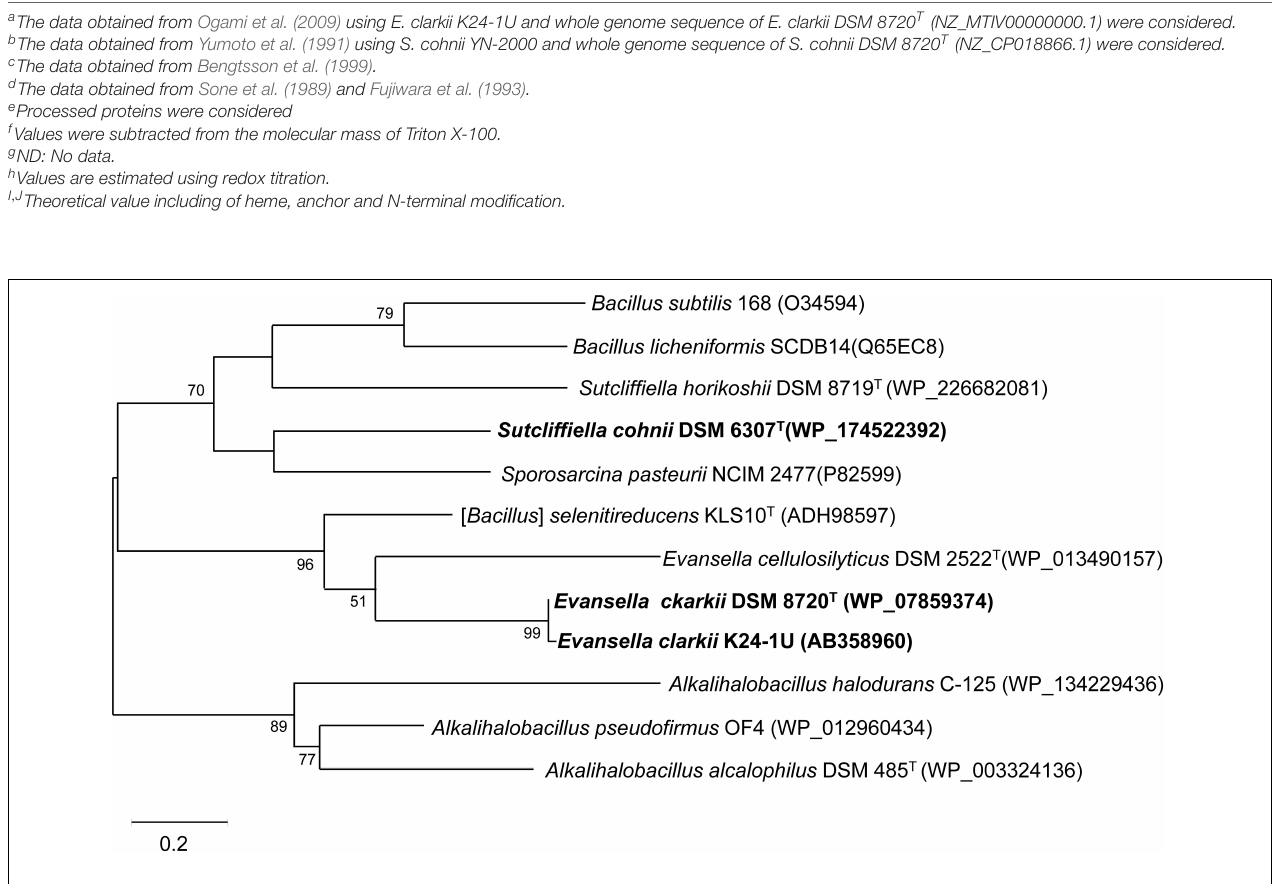
FIGURE 3 | Maximum-likelihood phylogenetic tree of membrane bound cytochromes c from Evansella clarkii and other alkaliphilic and neutralophilic Bacillaceae . The evolutionary history was inferred by using the Whelan and Goldman model (Whelan and Goldman, 2001). The tree with the highest log likelihood (-2371.51)